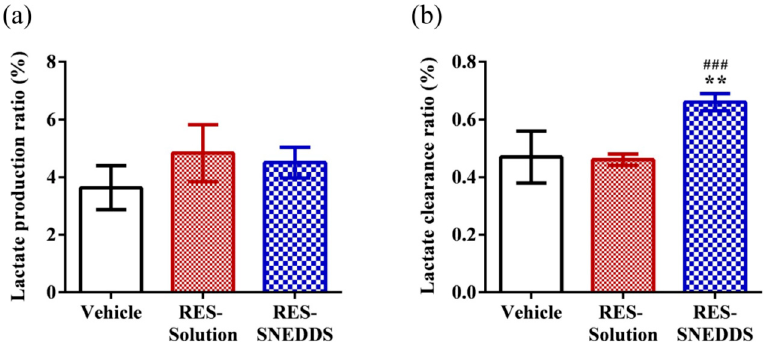
Figure 5. Effect of resveratrol (RES) on: ( a ) lactate production ratio; and ( b ) lactate clearance ratio. Data are expressed as mean ± standard error of the mean ( n = 5 for each group). ** p < 0.01 compared with vehicle group. ### p < 0.001 compared with RES-solution group. Lactate production ratio = (Lactate post-swimming − Lactate pre-swimming )/Lactate pre-swimming ; Lactate clearance ratio = (Lactate post-swimming − Lactate 30 min later after post-swimming )/Lactate post-swimming .